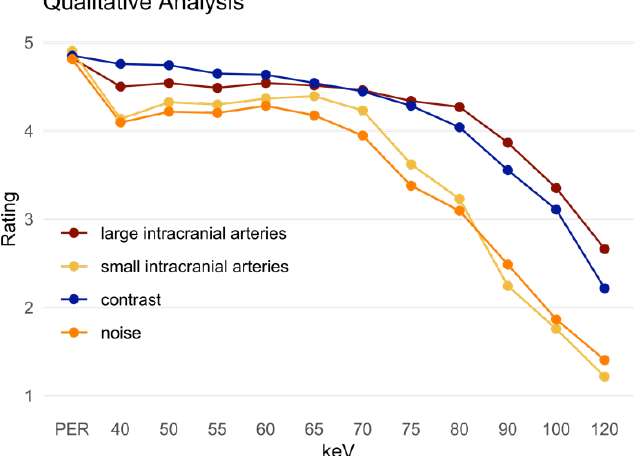
Figure 7. Qualitative analysis presented as the mean of the ratings. PER: polyenergetic reconstruction; keV: keV level of the monoenergetic reconstruction. Large intracranial arteries: assessment of the large intracranial arteries; small intracranial arteries: assessment of the distal cerebral arteries. Contrast: general image contrast. Noise: general image Table 2. Results of the qualitative analysis presented as mean ± standard deviation.